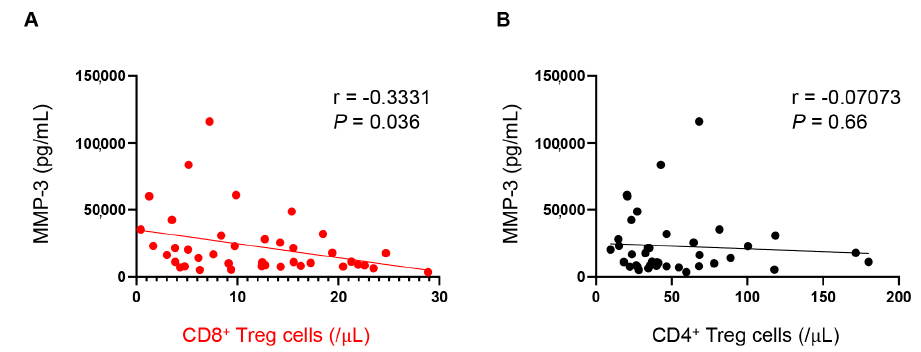
Figure 4. Inverse correlation between number of CD8 + , but not CD4 + regulatory T cells (Tregs), with plasma matrix metalloprotease (MMP)-3 levels. Associations between number of CD8 + Tregs ( A ) or CD4 + Tregs ( B ) and plasma MMP-3 levels were examined using Pearson correlation analysis ( n = 40).